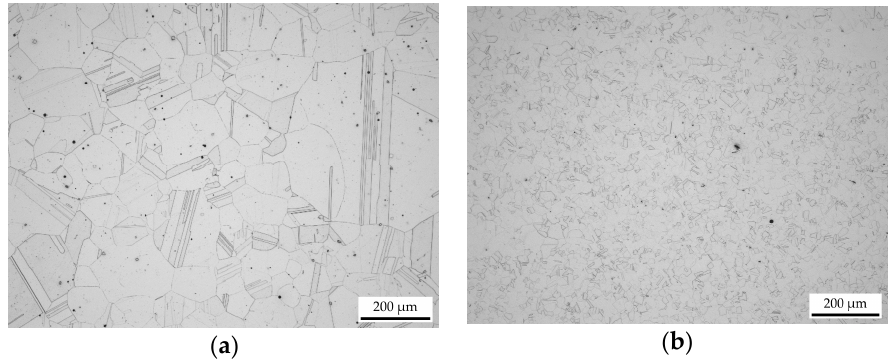
Figure 3. Microstructure of Alloy 800H in the ( a ) as-delivered state; and ( b ) after compression at 1100 °C with a strain rate of 1 s − 1 to a total strain of 80%. The compression axis runs parallel to the vertical image edge.